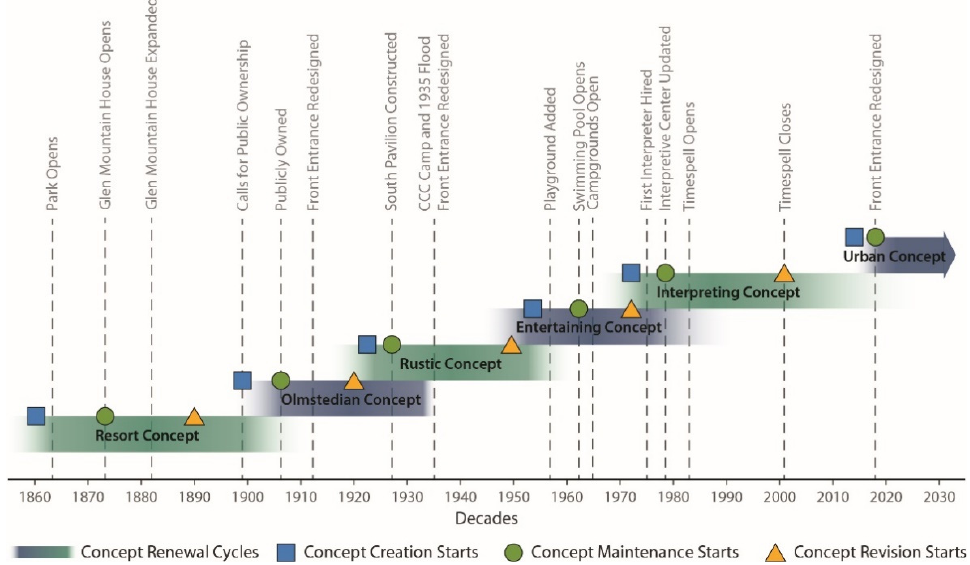
Figure 18. Concept Renewal Cycles at Watkins Glen State Park. Source: Author.